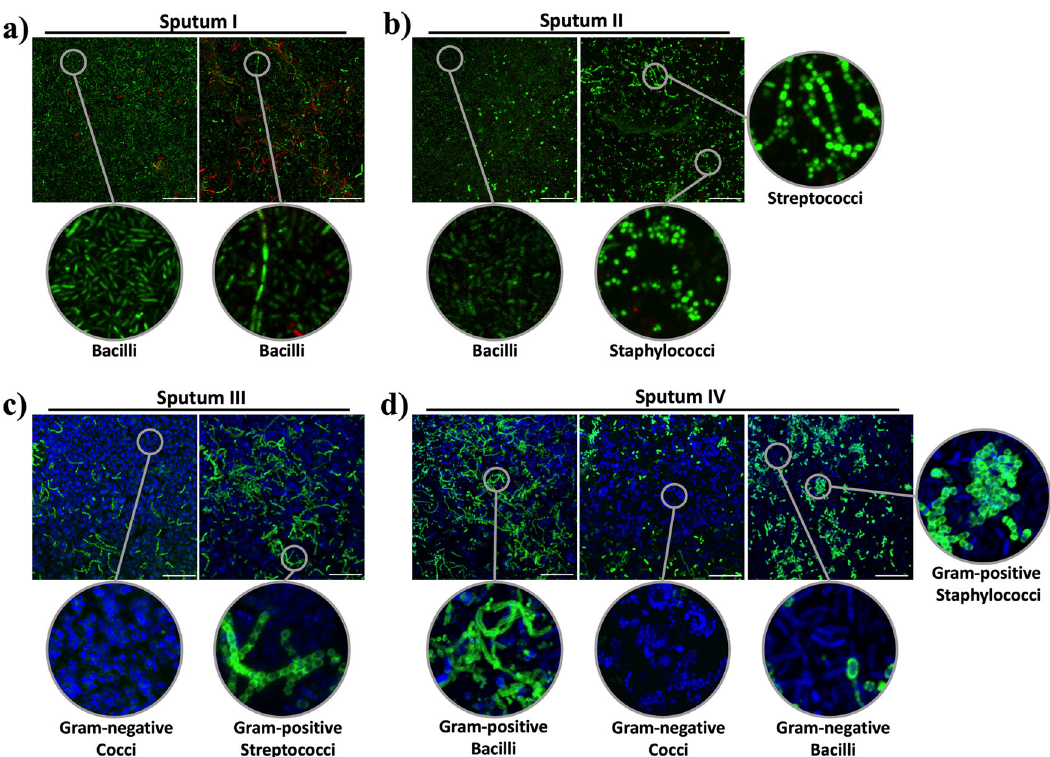
Fig. 4 Bio fi lms formed from four different sputum samples (I – IV) with enlarged images showing the different bacterial shapes found. Bio fi lms were stained with a LIVE/DEAD BacLight Bacterial Viability Kit ( a and b ) and with a Gram Stain Kit ( c and d ), which stains Gram- negative bacteria blue and Gram-positive bacteria green. Scale bar represents 20 μ m. The images shown are representative of one bio fi lm formed per each sputa, that was repeated at least two times, yielding the same results.